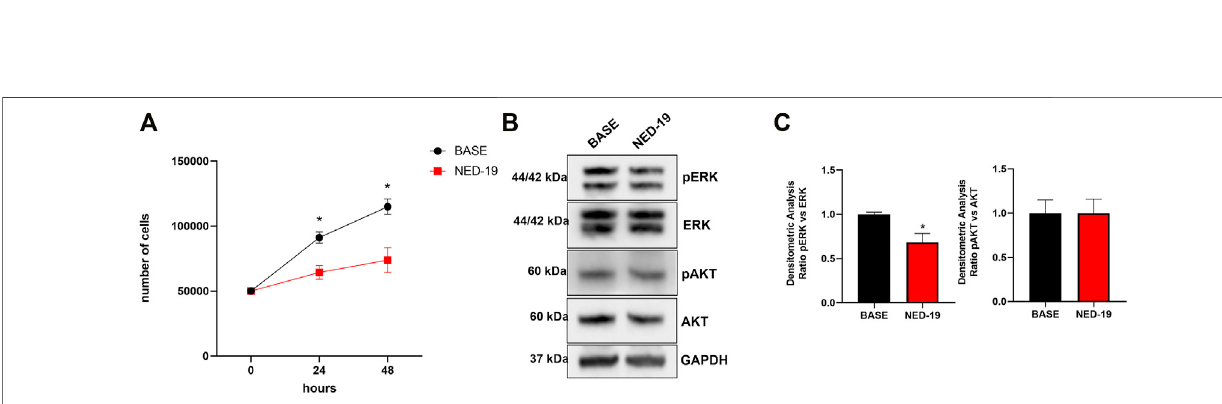
lysosomal Ca 2+ store with either GPN (200 μ M, 30 min) ( Figures 7A,B ) or nigericin (50 μ M, 30 min) ( Figures 7A,B ) abrogated FBS-induced intracellular Ca 2+ mobilization. The same effect was achieved upon pharmacological blockade of TPCs with NED-19